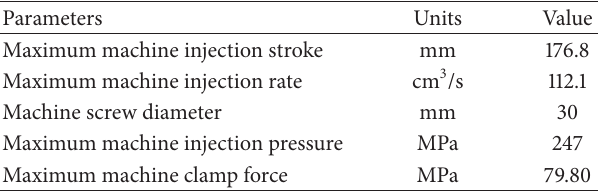
Table 1: Specifications of injection-moulding